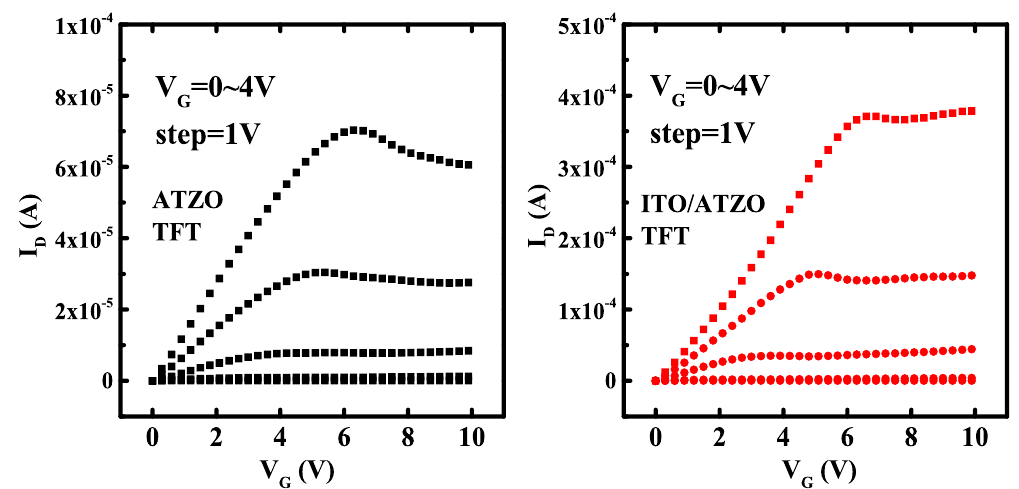
Figure 4. Output characteristics of (Left) single-channel ATZO and (Right) double-channel ITO/ATZO